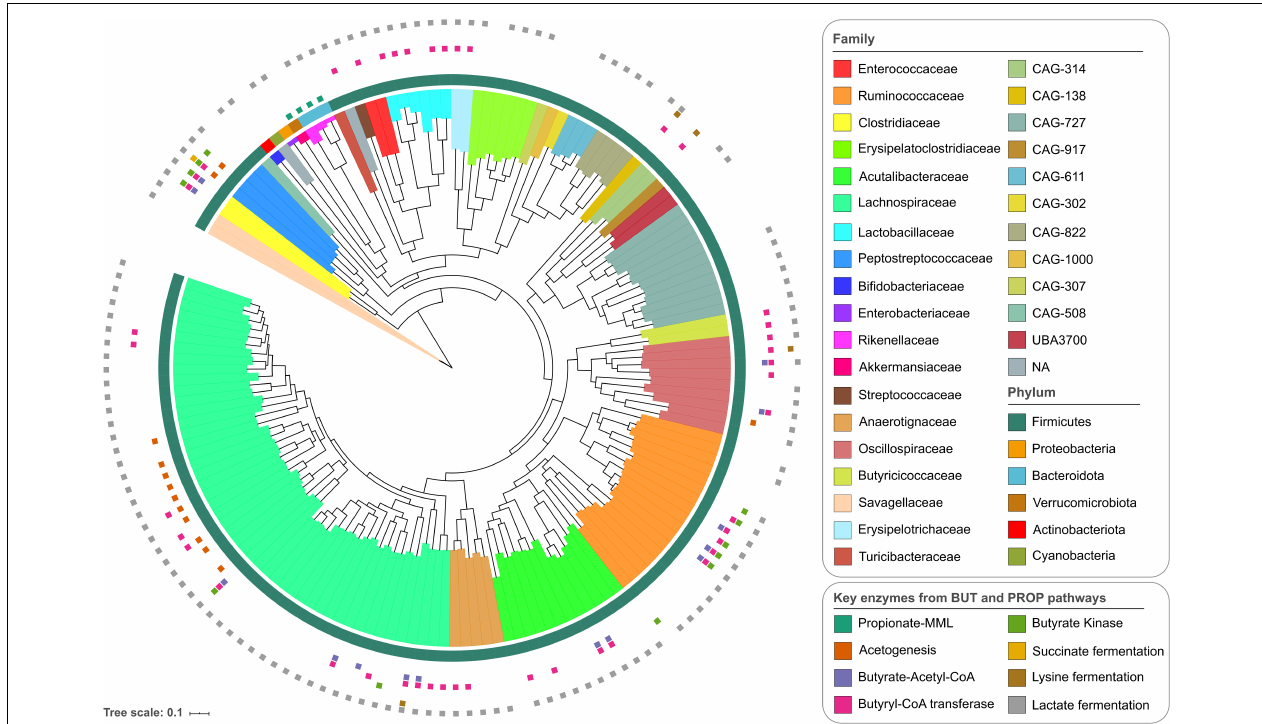
FIGURE 1 | Phylogenetic tree of the 155 metagenomic assembled genomes derived from the chicken gastrointestinal tract (GIT). The outer ring shows the annotations at the phylum level, and the internal coloring reflects the annotation at the family level. The small colored squares outside the phylogenetic tree indicate the presence of all enzymes for the butyrate and propionate production pathways: propionate-MML (methylmalonyl-CoA mutase, methylmalonyl-CoA epimerase, and Methylmalonyl-CoA decarboxylase); acetogenesis (acetyl-CoA synthase corrinoid iron-sulfur protein and 5-methyltetrahydrofolate); butyrate-Acetyl-CoA (3-hydroxybutyryl-CoA dehydrogenase, 3-hydroxybutyryl-CoA dehydratase, butyryl-CoA dehydrogenase, phosphate butyryltransferase); butyryl-CoA transferase; butyrate kinase; succinate fermentation (succinate-semialdehyde dehydrogenase, 4-hydroxybutyrate dehydrogenase, 4-hydroxybutanoyl-CoA dehydratase, succinyl-CoA synthetase); lysine fermentation (lysine 2,3-aminomutase, 3,5-diaminohexanoate dehydrogenase, 3-keto-5-aminohexanoate cleavage enzyme, 3-aminobutyryl-CoA ammonia-lyase); and lactate fermentation (lactate